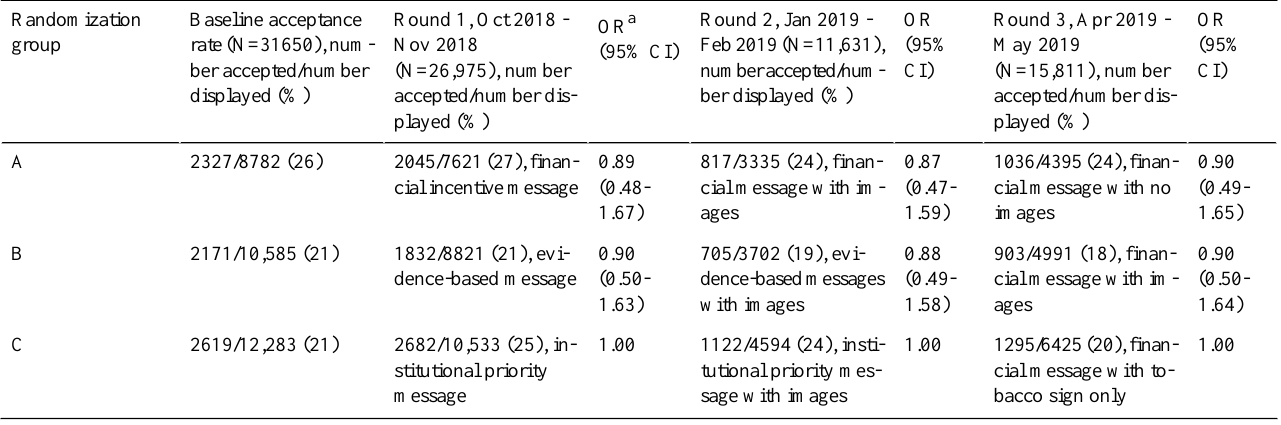
Table 2. Acceptance rates by alert type (encounter level acceptance rates; acceptance includes any positive action — perform counseling, prescribe therapy, or refer to state tobacco quit